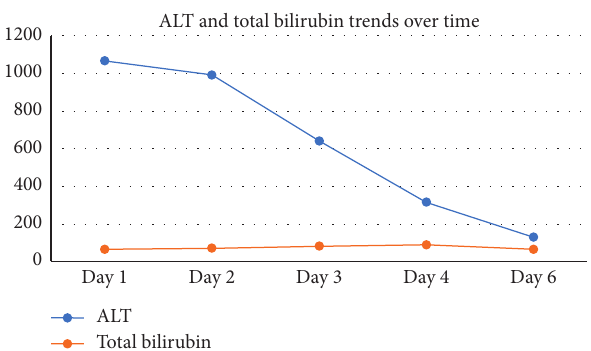
Figure 1: Trends of ALT and total bilirubin in the first 6 days of hospitalisation.